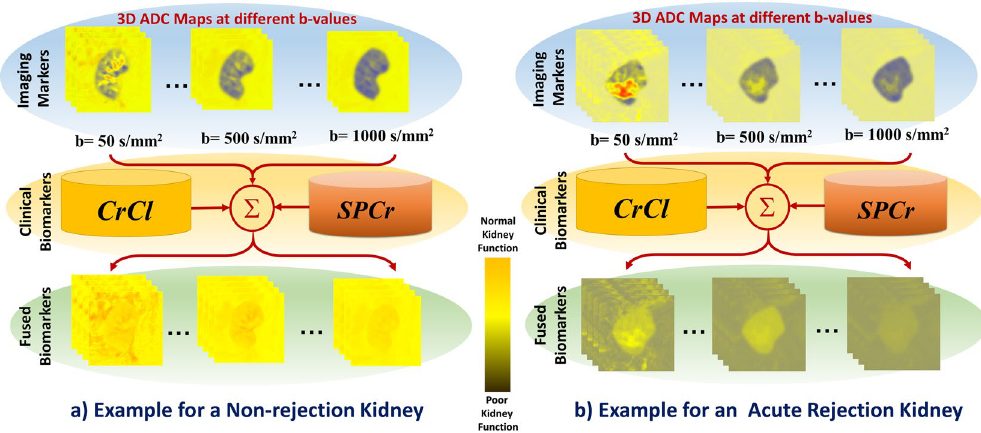
Figure 3. Demonstration of the efficacy of the fusion of both image and clinical markers. In this work, the estimated ADC maps are fused with the one dimensional (1D) CrCl and 1D SPCr values obtained during routine post-transplantation monitoring. The clinical biomarkers of each subject were first normalized with regard to the maximum values of each marker. Then, the normalized values were added to the voxel-wise ADC maps at all of the b-value scans. This difficult example differentiates an NR case ( a ) from an AR case ( b ). As illustrated in this figure, it is very difficult using the ADC maps alone to distinguish between the normal and abnormal subjects. This can be justified by the large overlap of the ADC values between these two subjects, which have been revealed by the color-coded maps. Visually, it is clear that the two subjects had a good color separation after the fusion process of both markers, where the dark-green color represents poor kidney function (i.e. low ADCs + low CrCl + high SPCr) and the orange-yellowish color represents a normal kidney function (i.e. high ADCs + high CrCl + low